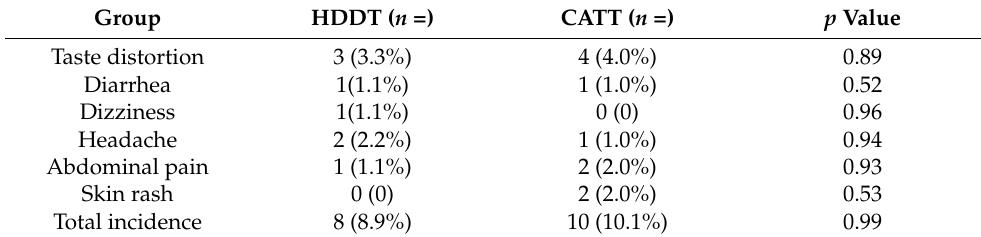
Table 2. Adverse effects in this